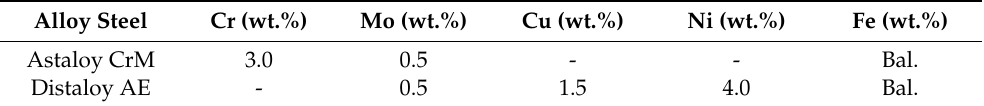
Table 1. Chemical compositions of materials. Alloy